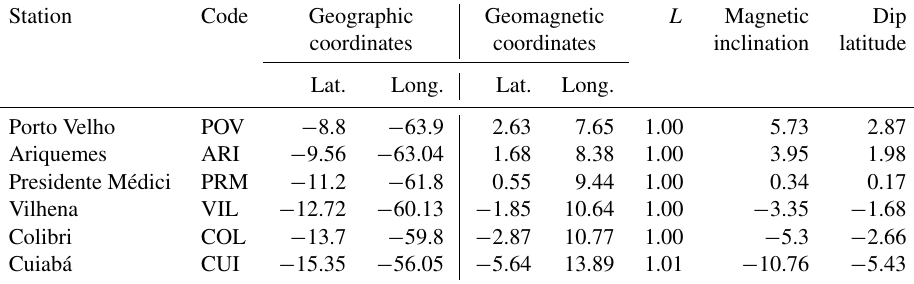
Table 1. Geomagnetic and geographic information of the six geomagnetic stations. Station Code Geographic Geomagnetic L Magnetic Dip coordinates coordinates inclination latitude Lat. Long. Lat. Long. Porto Velho POV − 8.8 − 63.9 Ariquemes